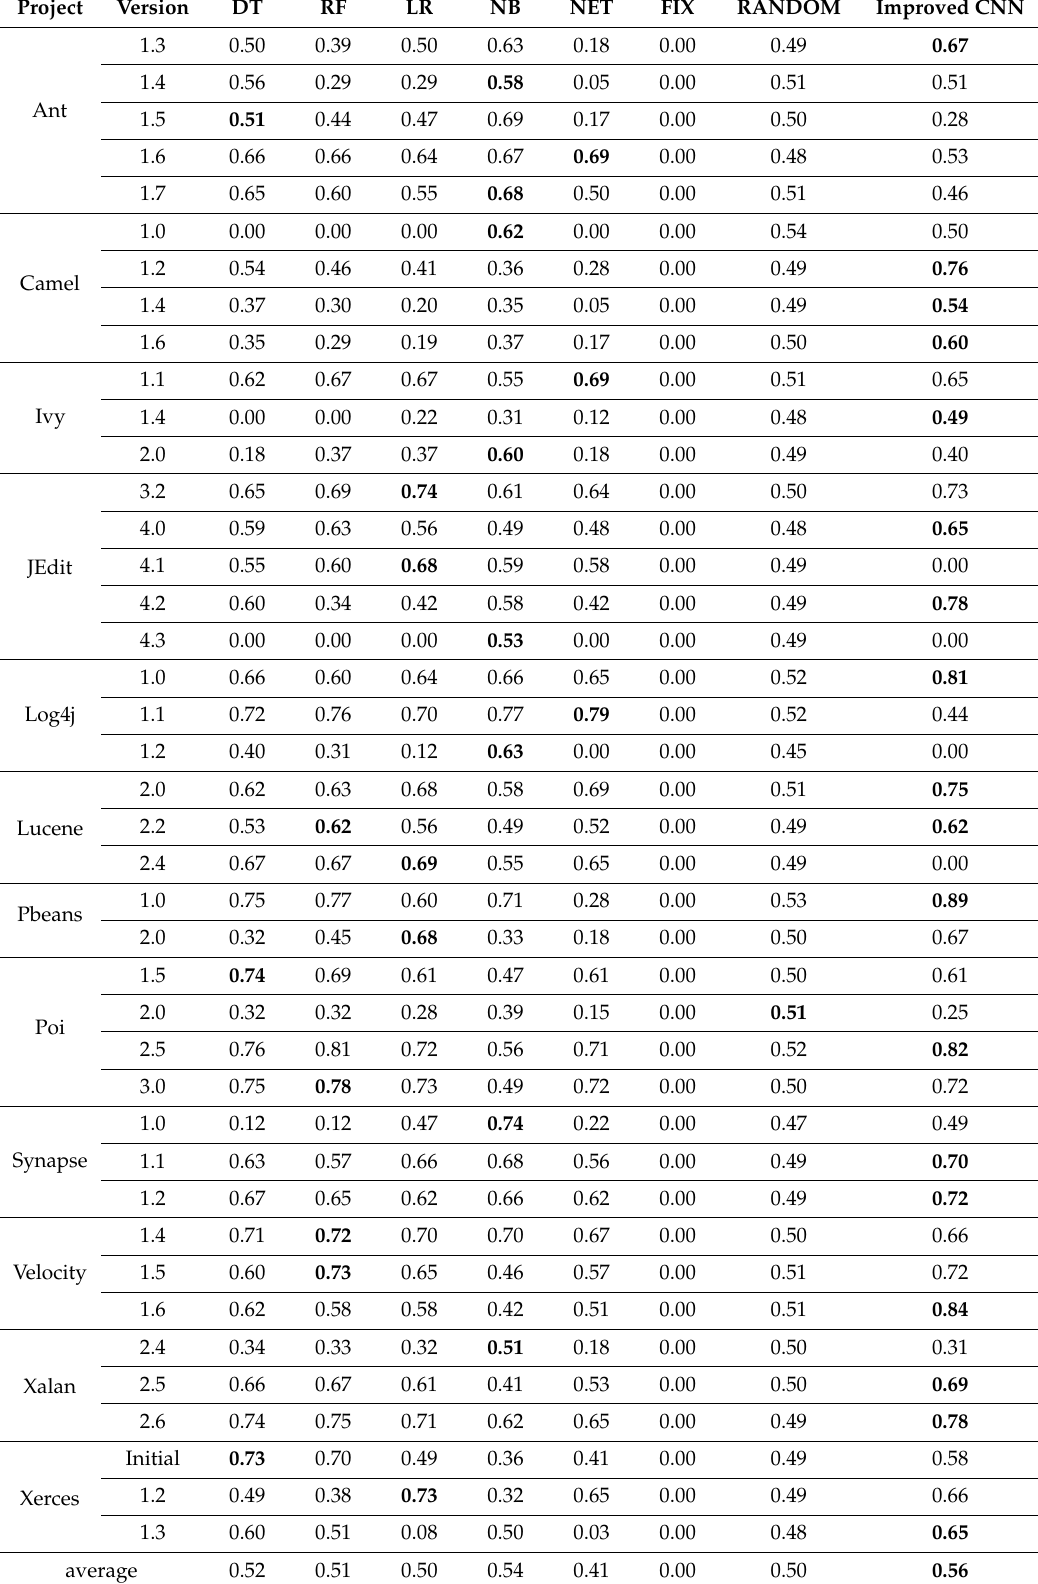
Table 7. Performance comparison of di ff erent models on the PSC dataset. The decimal values represent the average G-measure values. The best G-measures for each row are highlighted in bold.